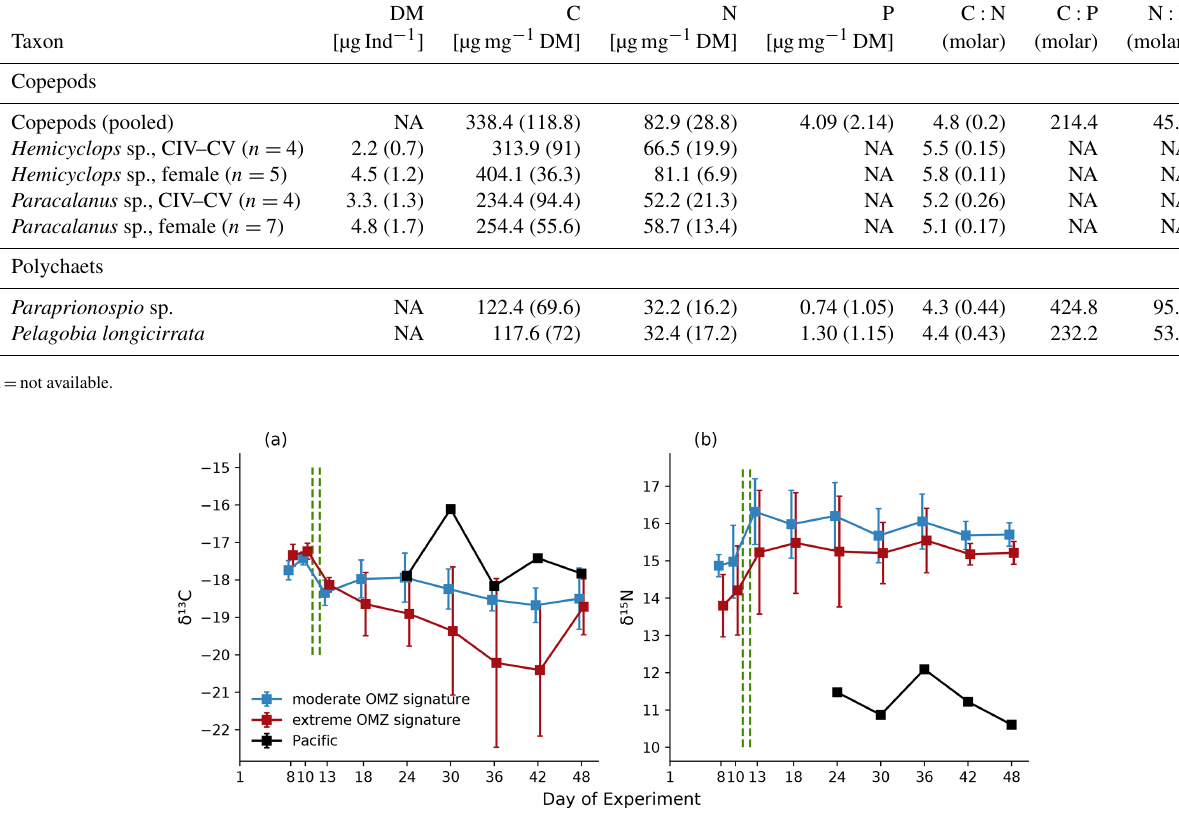
Figure 9. Temporal development averaged for the moderate and extreme treatments of δ 13 C (a) and δ 15 N (b) in copepods sampled in the eight mesocosms and the adjacent Pacific. Error bars depict 95% confidence intervals. The green vertical dashed lines indicate the days of OMZ water additions. The experimental phase 1 lasted from day 1 until day 11–12, phase 2 until day 40, and phase 3 until experiment